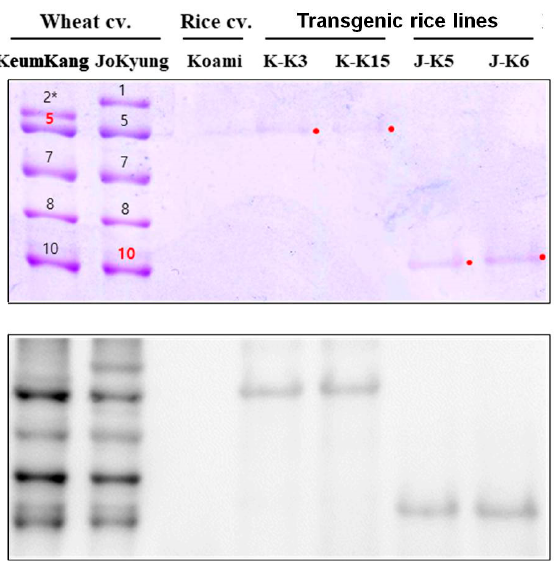
Figure 3. SDS-PAGE (12.5%) and immunoblot analyses of 1Dx5_KK and 1Dy10_JK expression in mature seeds of wheat cultivars KeumKang and JoKyung, rice cultivar Koami (wild-type), and KK and JK independent transgenic rice lines expressing 1Dx5_KK and 1Dy10_JK , respectively. Membranes were hybridized with HMW-GS polyclonal antibodies. Number 1, 2*, 5, 7, 8, 10 in wheat cultivar (cv.) KeumKang and JoKyung indicate the allelic composition of glutelin as 1Ax1, 1Ax2*, 1Dx5 (upper red number and point), 1Bx7, 1By8, and 1Dy10 (lower red number and point).